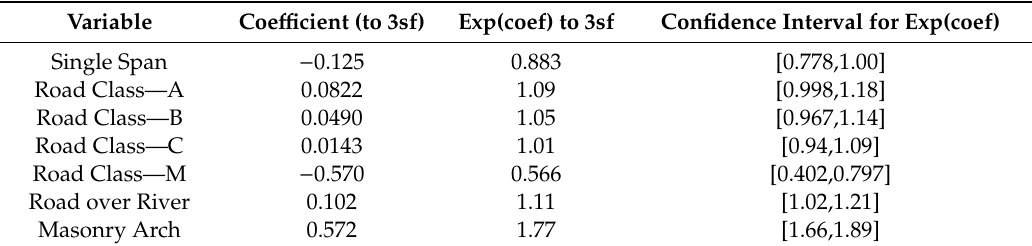
Table 3. A table showing the value of coe ffi cients, the exponential of these coe ffi cients and the confidence intervals of the exponential of the coe ffi cient for the significant variables in Cox Proportional Hazards model for time in condition state 1. Variable Coe ffi cient (to